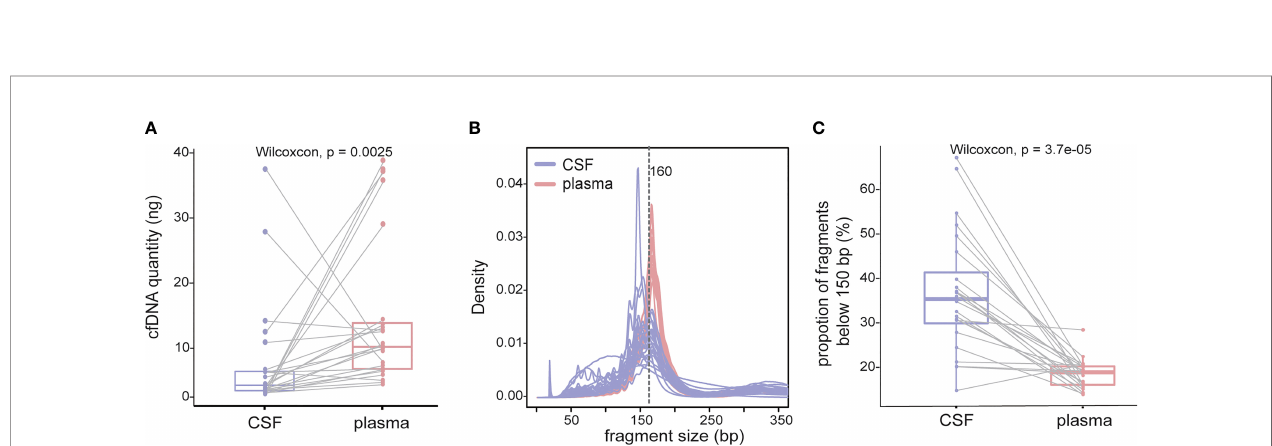
FIGURE 2 | cfDNA fragments are shorter in CSF than those in plasma. cfDNAs were extracted from 24 CSF samples and matched plasma samples, and the size of cfDNA was analyzed by low-coverage WGS (3×). (A) cfDNA yield between 5 ml CSF (violet) and 5 ml plasma (red) from 24 NSCLC patients with LM. (B) Size distribution of cfDNA fragments between CSF samples and matched plasma samples. (C) Proportion of cfDNA fragments below 150 bp in size in CSF samples and matched plasma samples. Each dot represents each sample, and each line connects matching